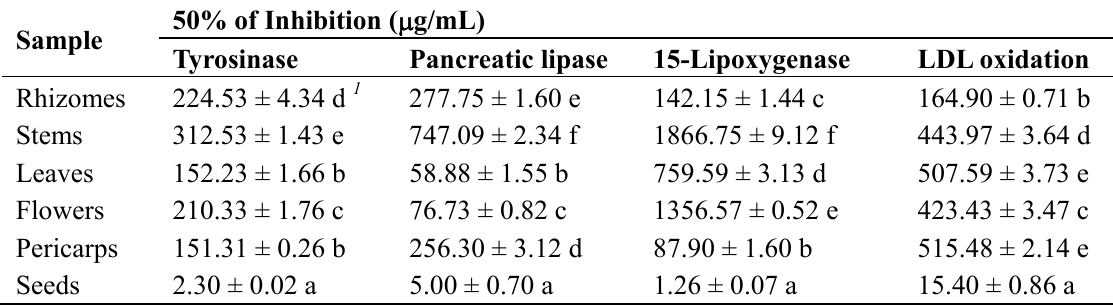
Table 2. Inhibitory effect of acetone extracts from various parts of A. zerumbet on tyrosinase, pancreatic lipase, 15-lipoxygenase and LDL oxidation activities.